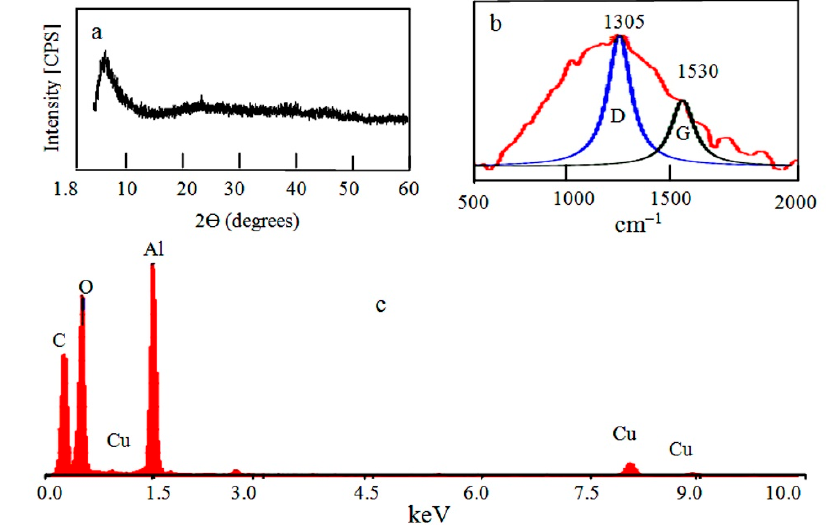
Figure 2. The prepared nanocomposite NC-1: ( a ) X-ray diffraction, ( b ) Raman spectrum, and ( c ) energy-dispersive X-ray spectrometry (EDX) analysis.